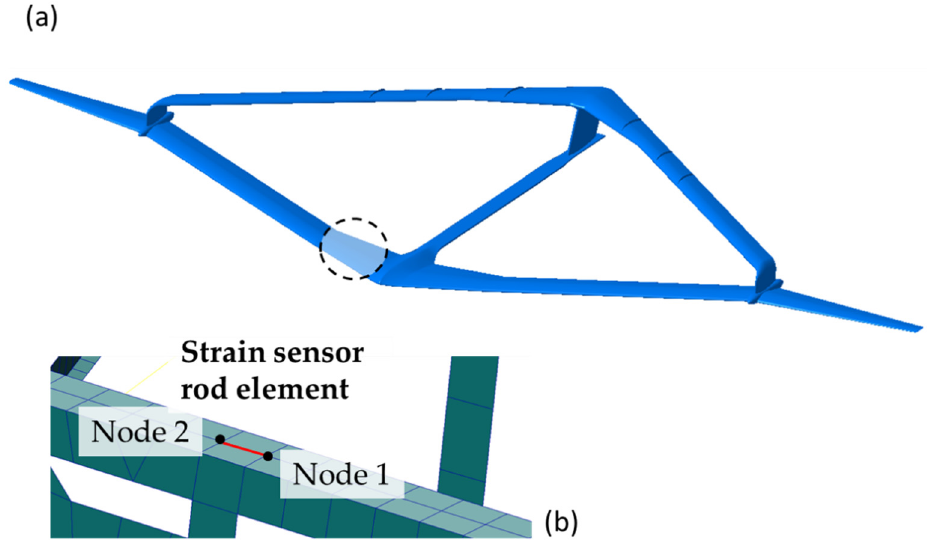
Figure 8. ( a ) FE model and ( b ) zoom on the front spar of the front wing and a rod element to simulate strain sensor.